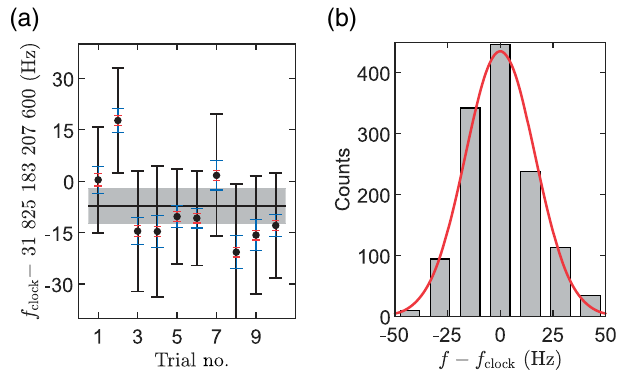
FIG. 5. (a) Absolute frequency of the clock transition measured over ten trials (filled black circles) with all known frequency offsets corrected, including that of the local Rb time base (see main text for details). Blue error bars are 1 σ statistical uncer- tainties, dominated by the determination of the comb repetition rate rather than the stability of the scanned molecular clock lines. Red error bars are 1 σ systematic uncertainties due to the molecular clock only (see Table I). Black error bars are 1 σ total uncertainties, where the uncertainties of the local time-base calibrations are added in quadrature with the statistical and molecular clock systematic uncertainties. The black horizontal line shows the weighted average ( χ 2 ¼ 0 . 5 ), and the shaded gray red area shows the associated (cid:4) 1 σ standard error of the mean. (b) Histogram of all clock frequency measurements in the ten trials, relative to the weighted average of f . The solid red line clock is a Gaussian fit to the